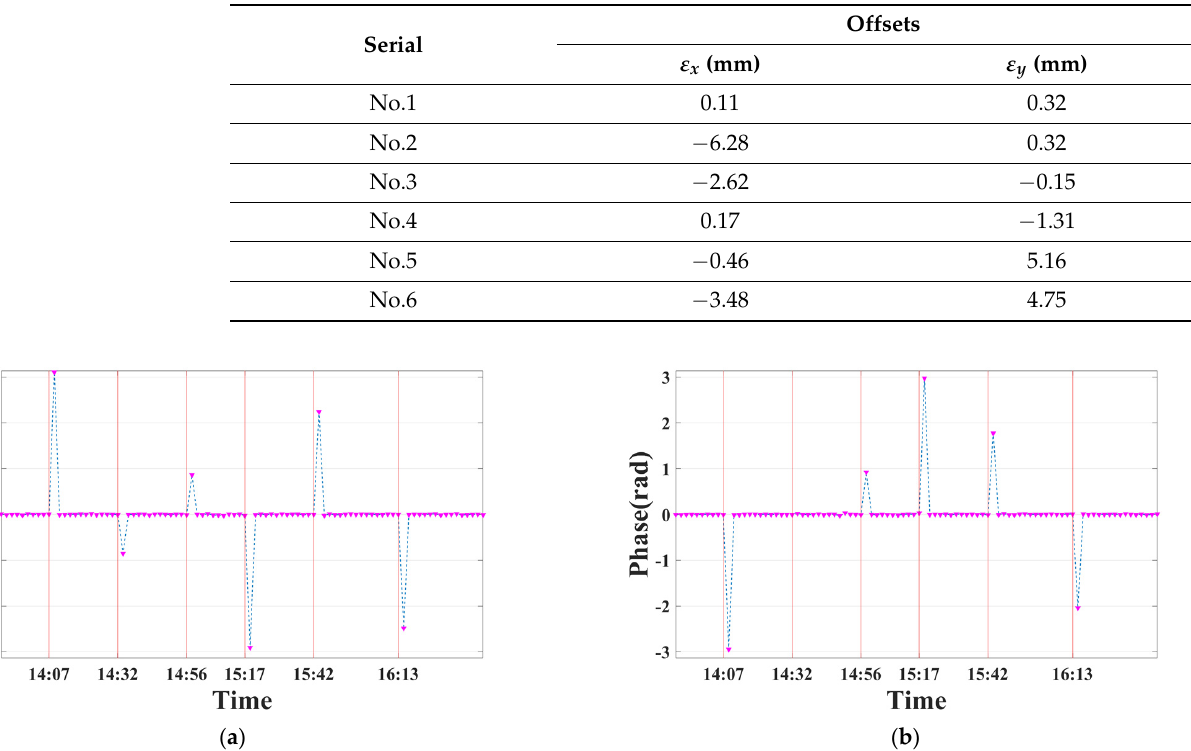
Figure 9. Comparison of theoretical value and experimental data from both two CRs: ( a ) CR 1 ; ( b ) CR 2 . 4.1.3. Error Compensation Consider M i as the master image and M i +1 as the slave image ( i = 1, 2, …6), 6 coherence maps are acquired, the average coherence map is shown in Figure 10a. As mentioned in Section 3, the coherence method is used to select PSs in discontinuous mode. Set the co- herence threshold as 0.98 and the SNR threshold as 30 dB, 51,387 PSs are obtained, which